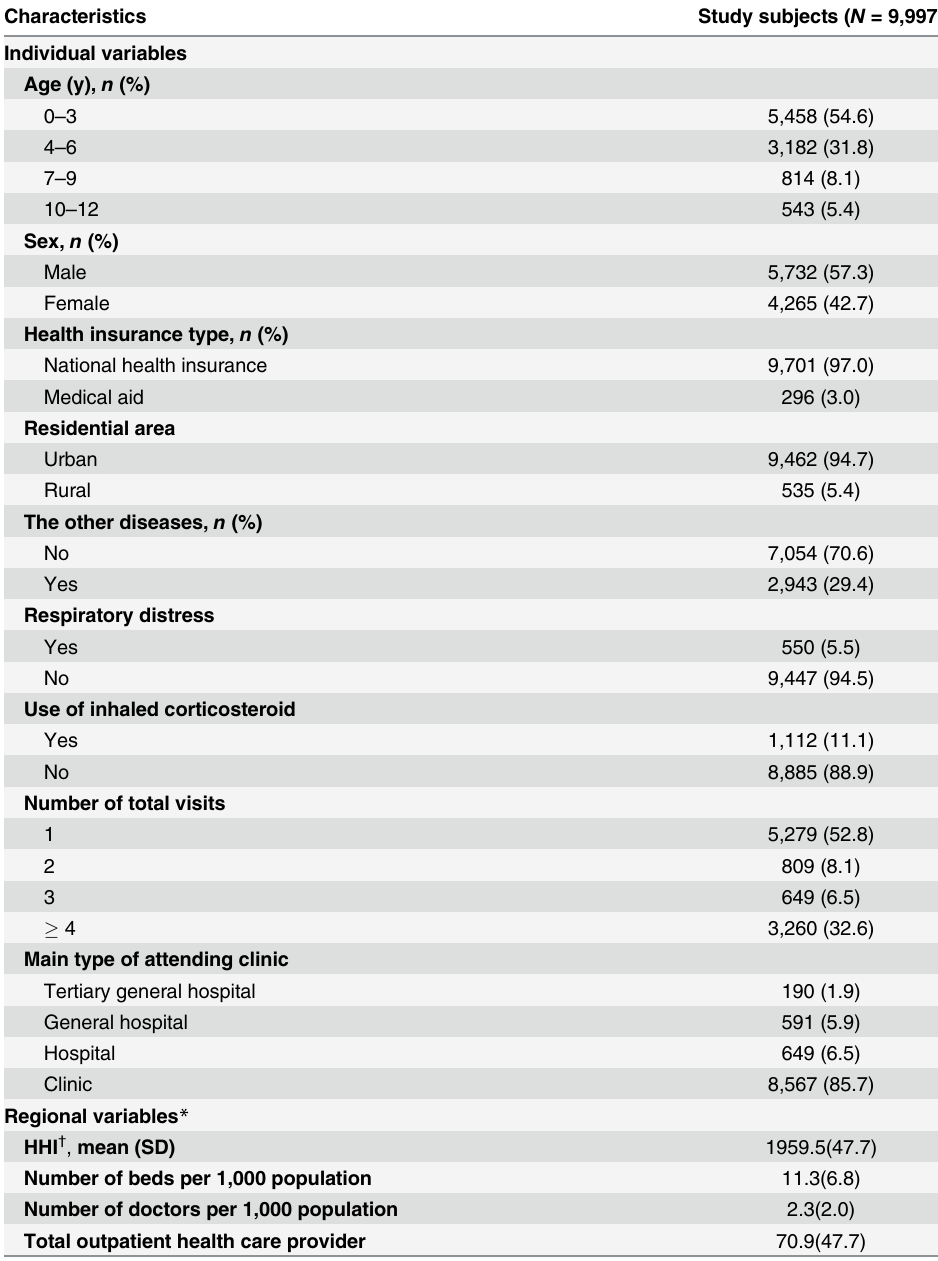
Table 1. Baseline characteristics of study